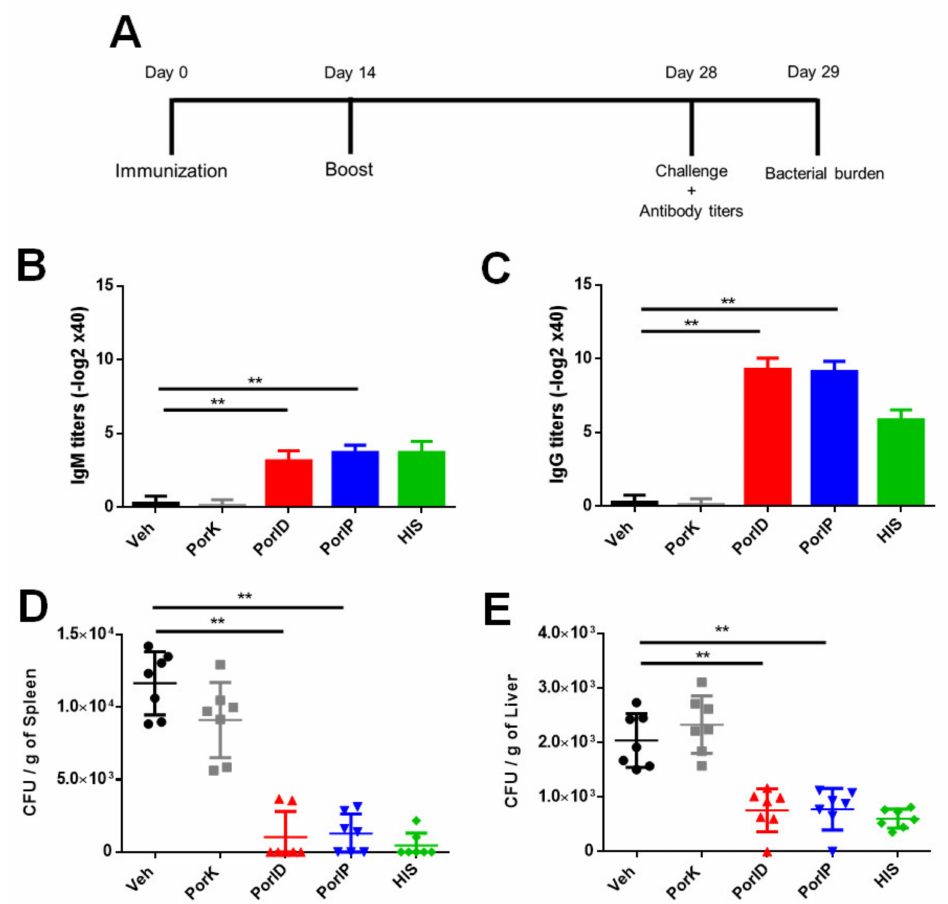
Figure 4. Vaccination with S. Typhi porins reduces the bacterial burden following challenge. C57BL/6J mice were injected intradermally in the ear with vehicle (Veh), proteinase K-digested porins (PorK), porins (PorID), or intraperitoneally with porins (PorIP) or heat-inactivated S . Typhi (HIS) at day 0 with a homologous boost at day 14 ( A ). At day 28, IgM ( B ) and IgG ( C ) serum titers were measured, and mice were challenged intraperitoneally with 10 5 S . Typhi CFU. At day 29, bacterial burden in the spleen ( D ) and liver ( E ) was determined ( n = 7; 3 independent experiments; significant difference for a Kruskal–Wallis test ** p < 0.05 with Dunn’s multiple